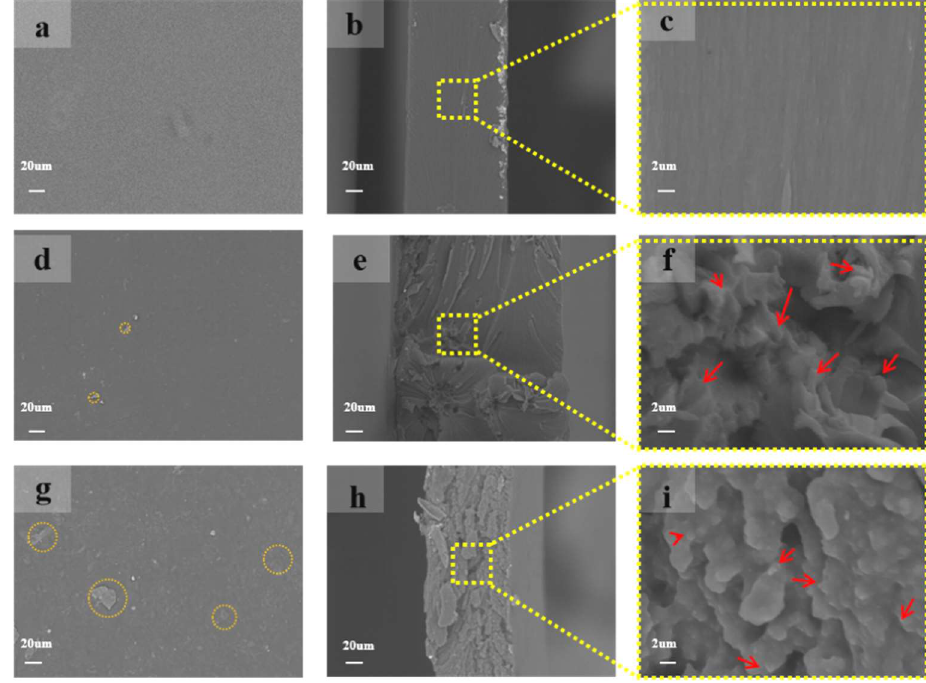
Figure 4. Morphology of ( a ) surface and ( b , c ) cross-section of PVA film, ( d ) surface and ( e , f ) cross- section of LPP1 film, ( g ) surface and ( h , i ) cross-section of LPP4 film.